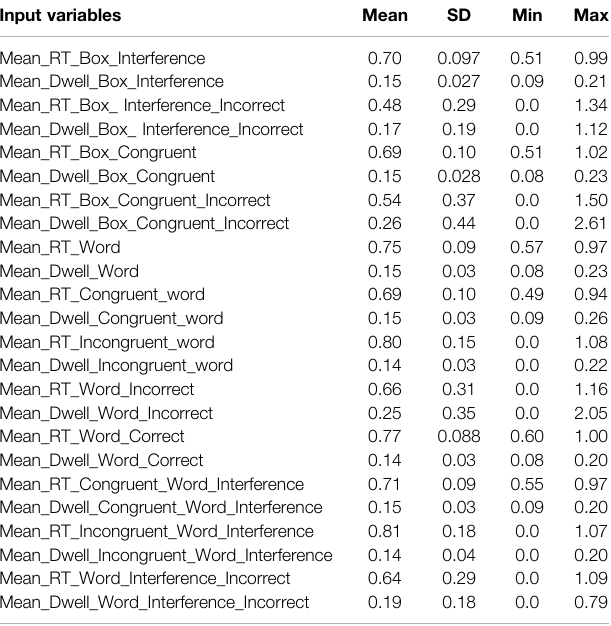
TABLE 2 | Descriptives of inputs variables. Input